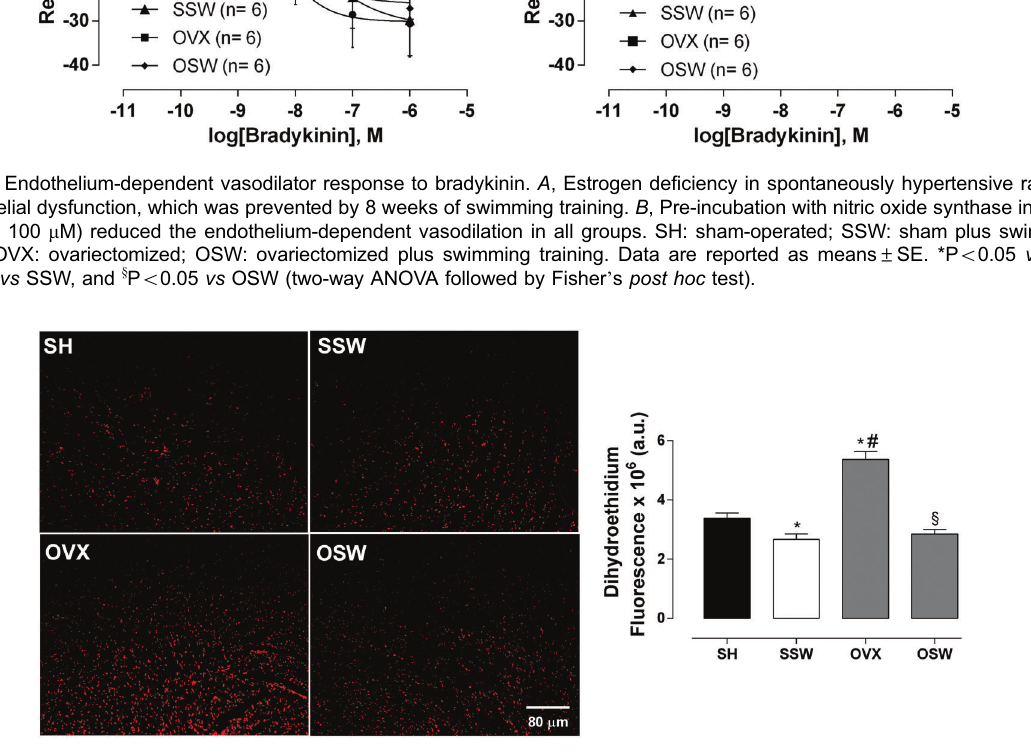
Figure 2. Analysis of superoxide production in cardiac sections by the dihydroethidium fl uorescence. SH: sham-operated; SSW: sham plus swimming training; OVX: ovariectomized; OSW: ovariectomized plus swimming training. Data are reported as means ± SE for